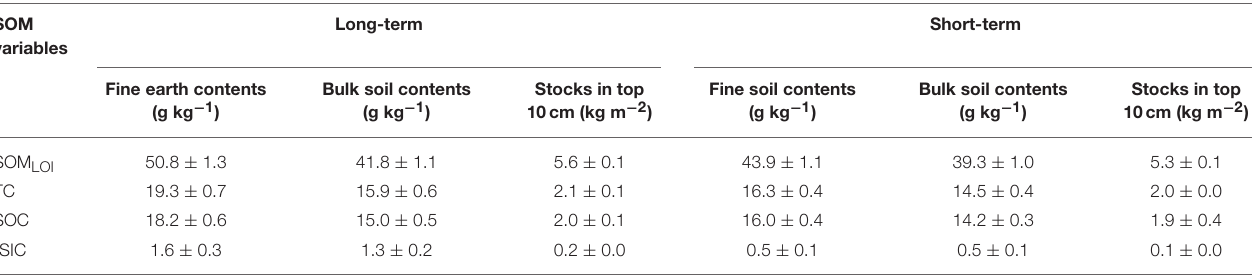
TABLE 2 | Mean contents and stocks of SOM variables in the long-term and the short-term urban soils. SOM Long-term variables